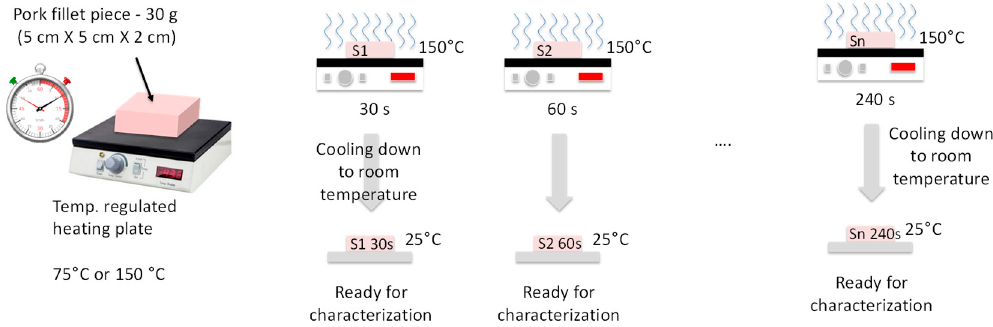
Figure 2. Continuous sample-heating procedure (CHP).